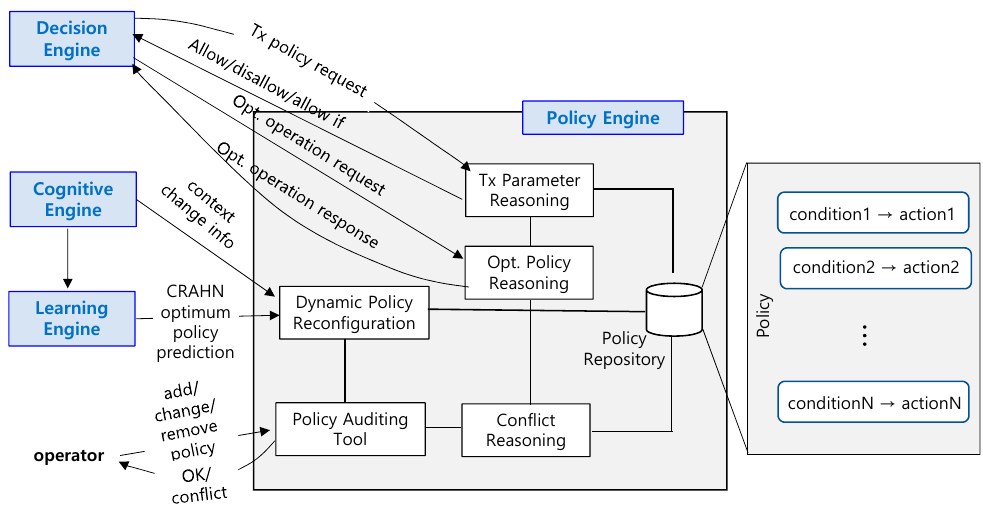
Figure 6. Proposed policy engine architecture.